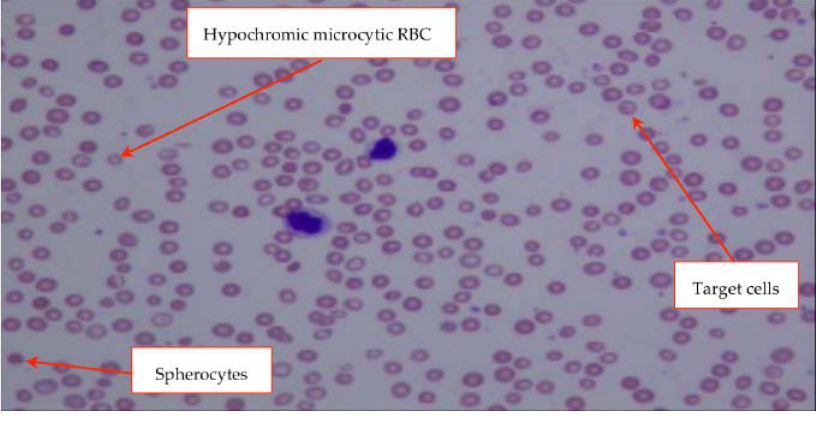
Figure 1. Peripheral blood smears film using May-Grünwald-Giemsa staining shows neg- ative sickle cell of Hb G-Makassar.